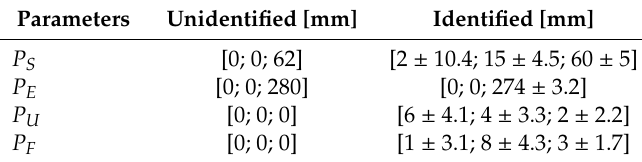
Table 2. Identified results of uncertain parameters of the exoskeleton working with Subject B.